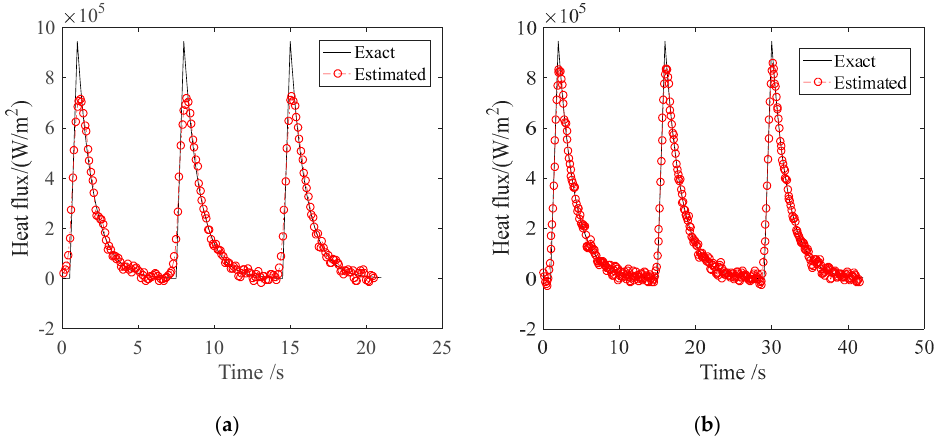
Figure 9. Inverse solution of heat flux under continuous shooting: ( a ) t dur = 7 s; and ( b ) t dur = 14 s with σ = 0.10 °C and r = 6 Table 5. Error analysis for heat flux inversion under continuous shooting.